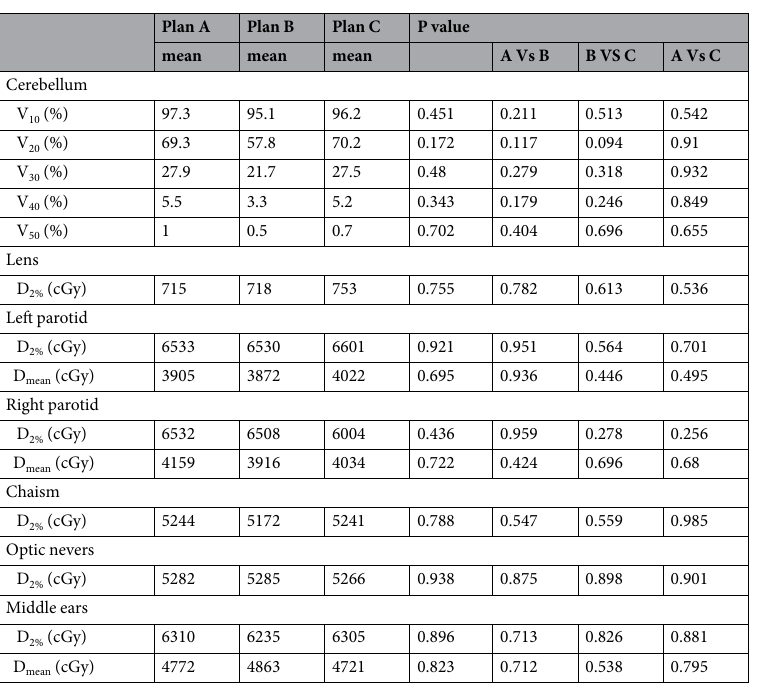
Table 4. The doses to other OARs.(Plan A: C-VMAT, Plan B: HS-VMAT, PlanC: